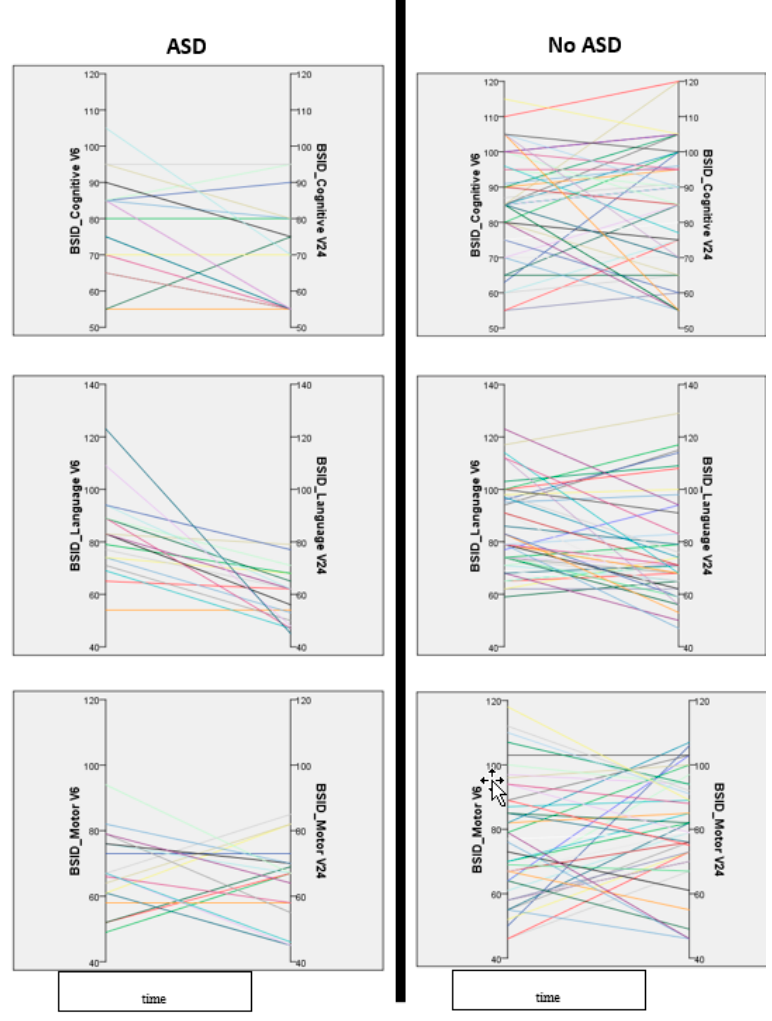
Figure 2. Individual developmental trajectories (every single infant is represented by a different color) in the three areas explored by BSID (cognitive, language, and motor), representing the changes of DQ over time (six to 24 months of age). Left column contains data of children with a diagnosis of autism spectrum disorder (ASD) at 24 months, right column those of children without ASD.